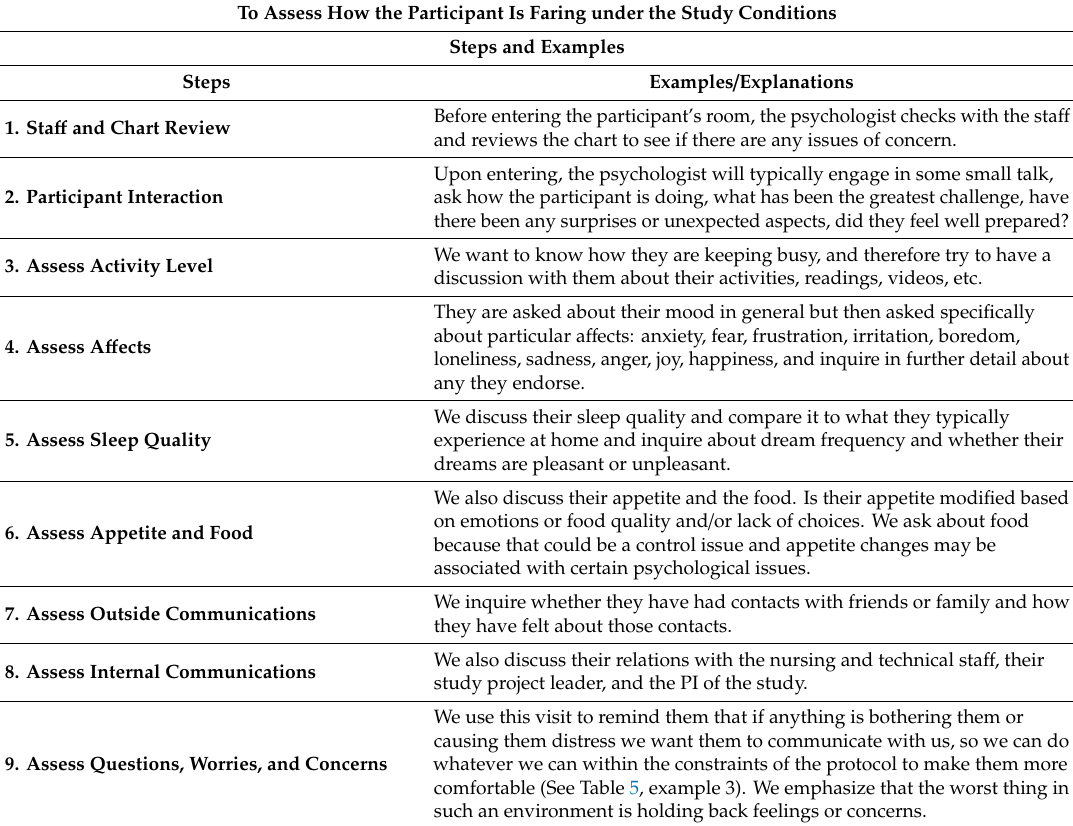
Table 6. The in-study visit